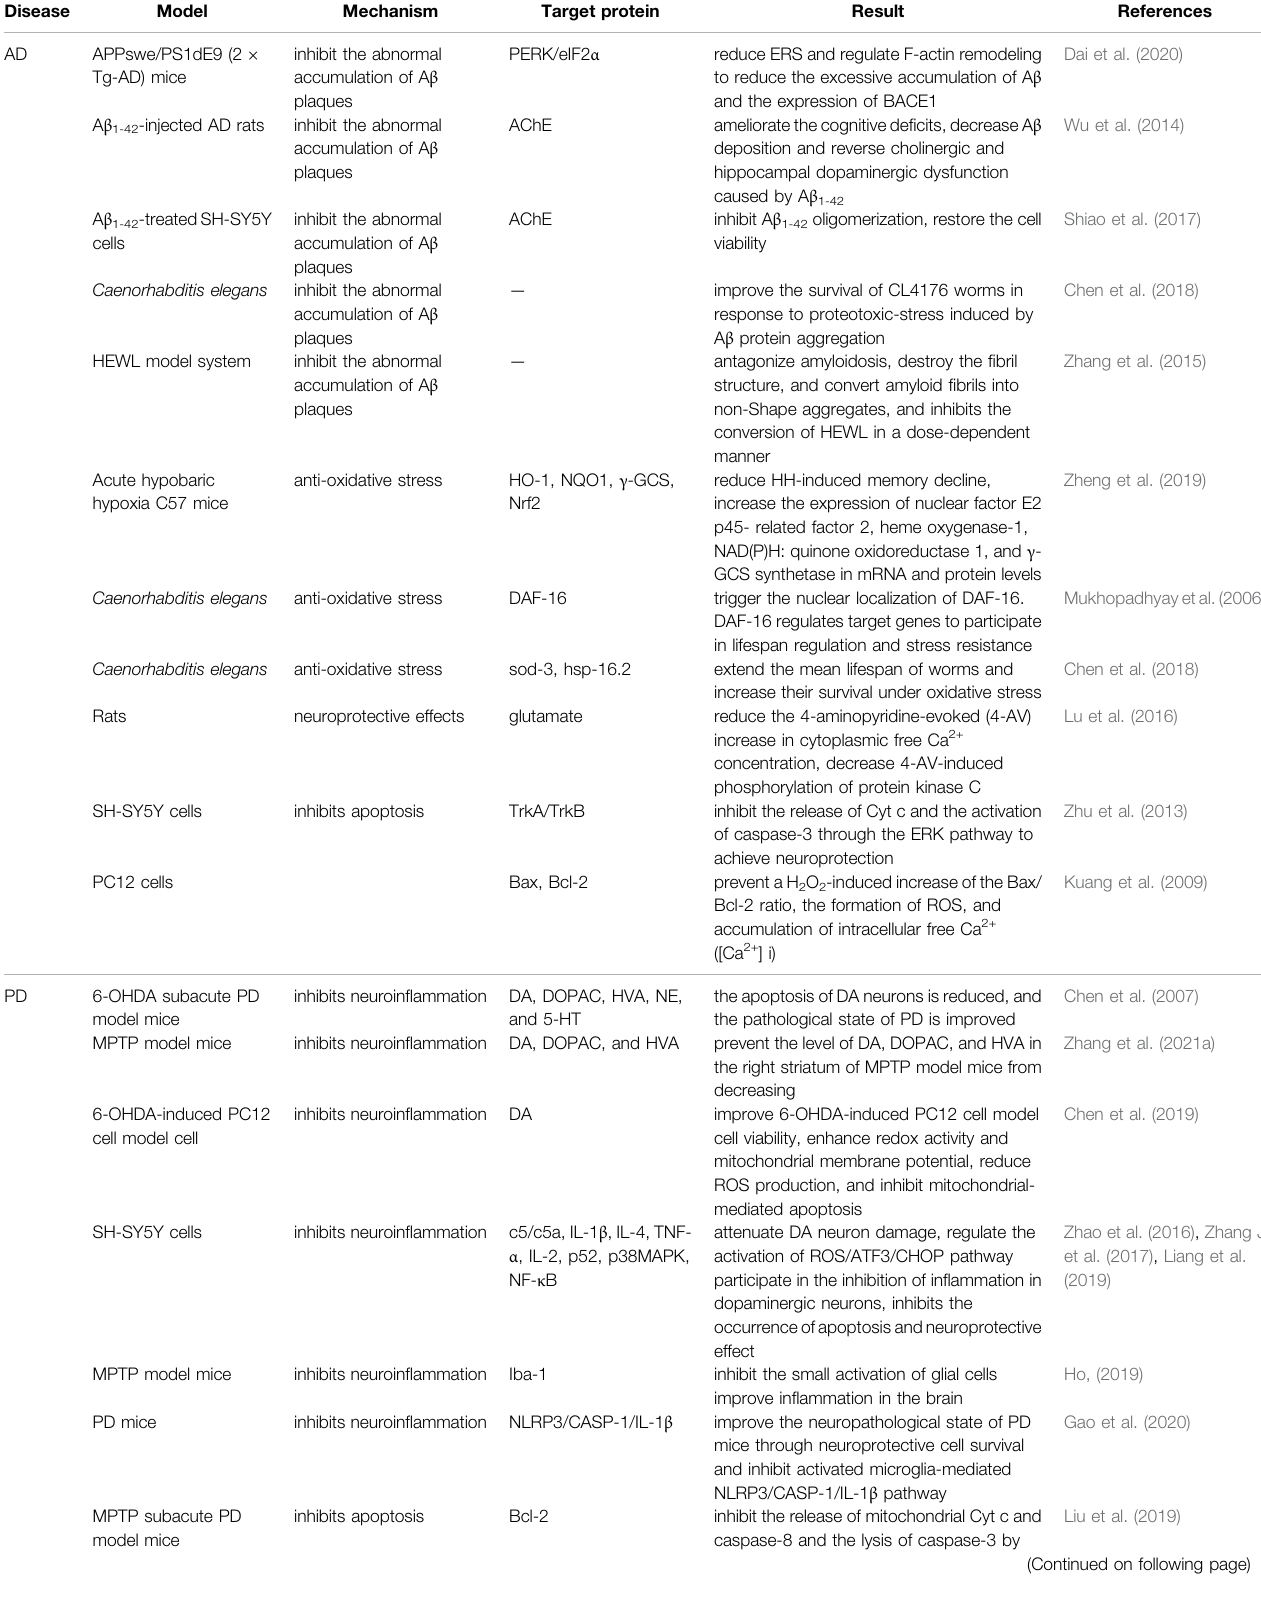
TABLE 1 | Neuroprotective effects of Echinacoside against neurodegenerative